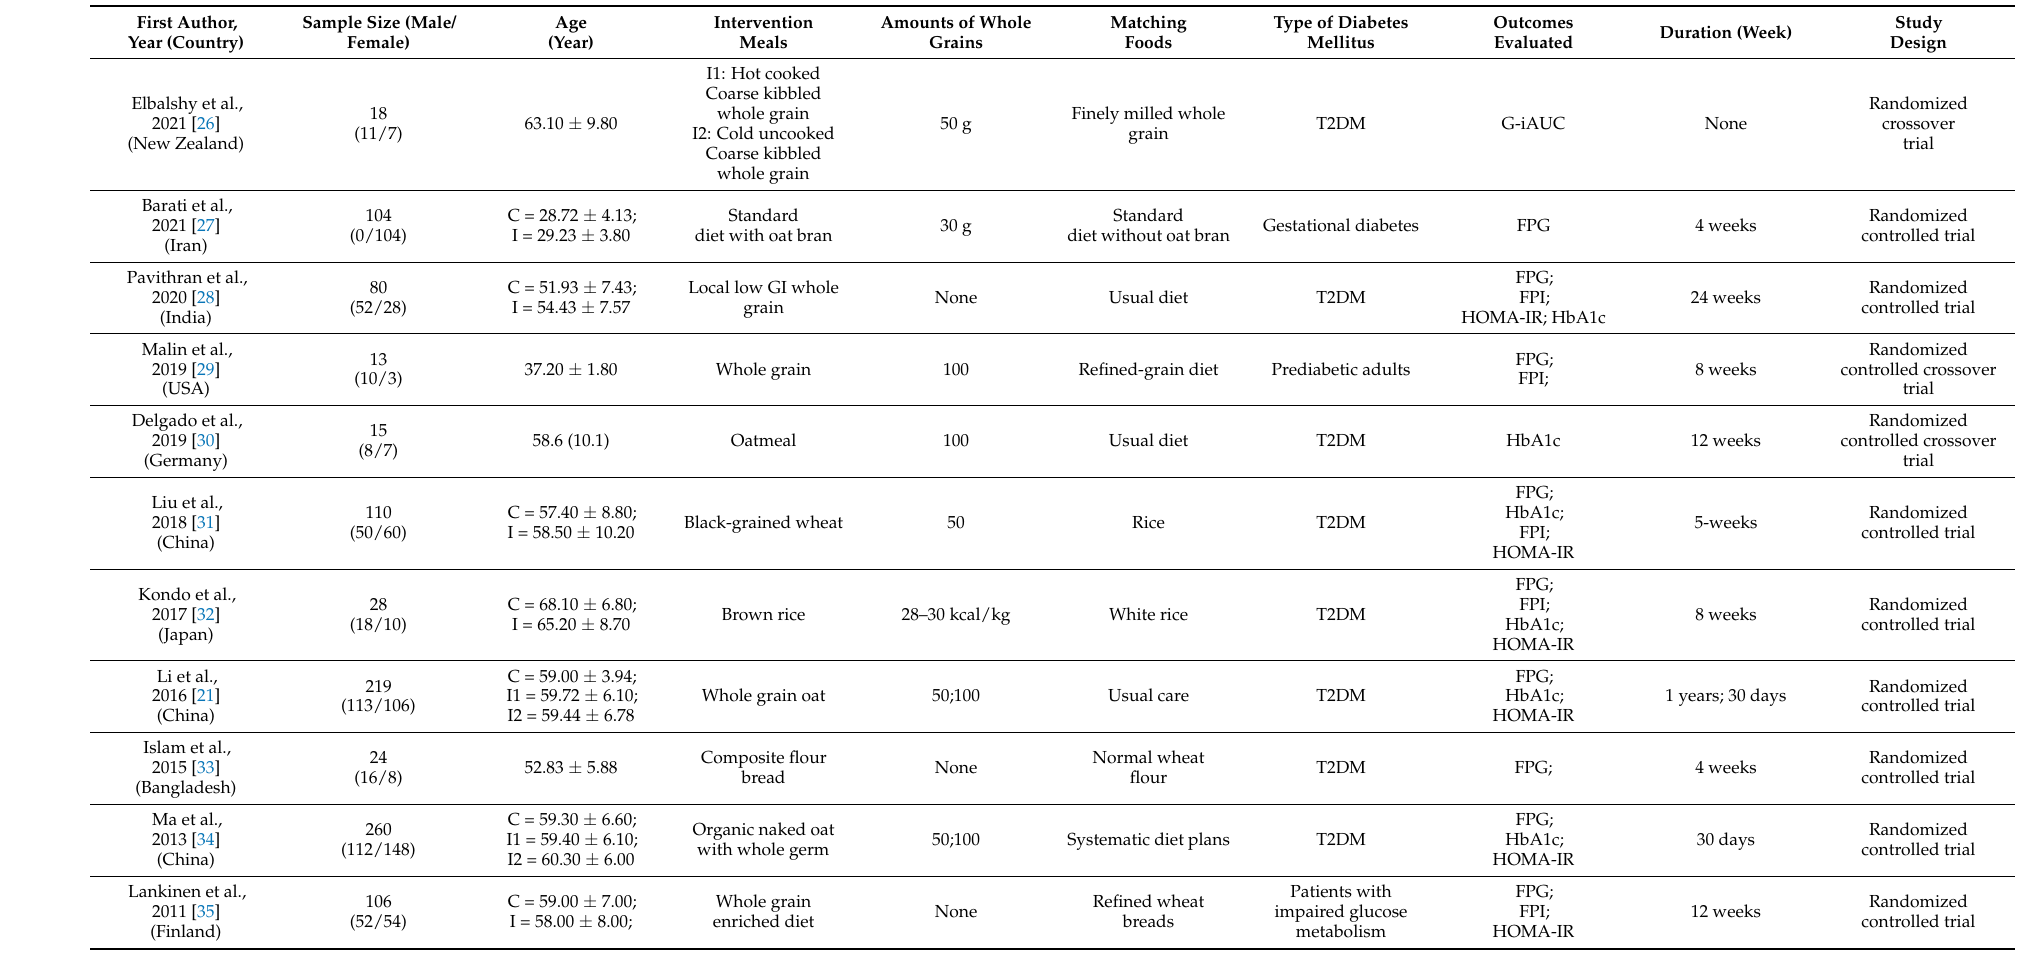
Table 1. Characteristics of included 16 trials for present